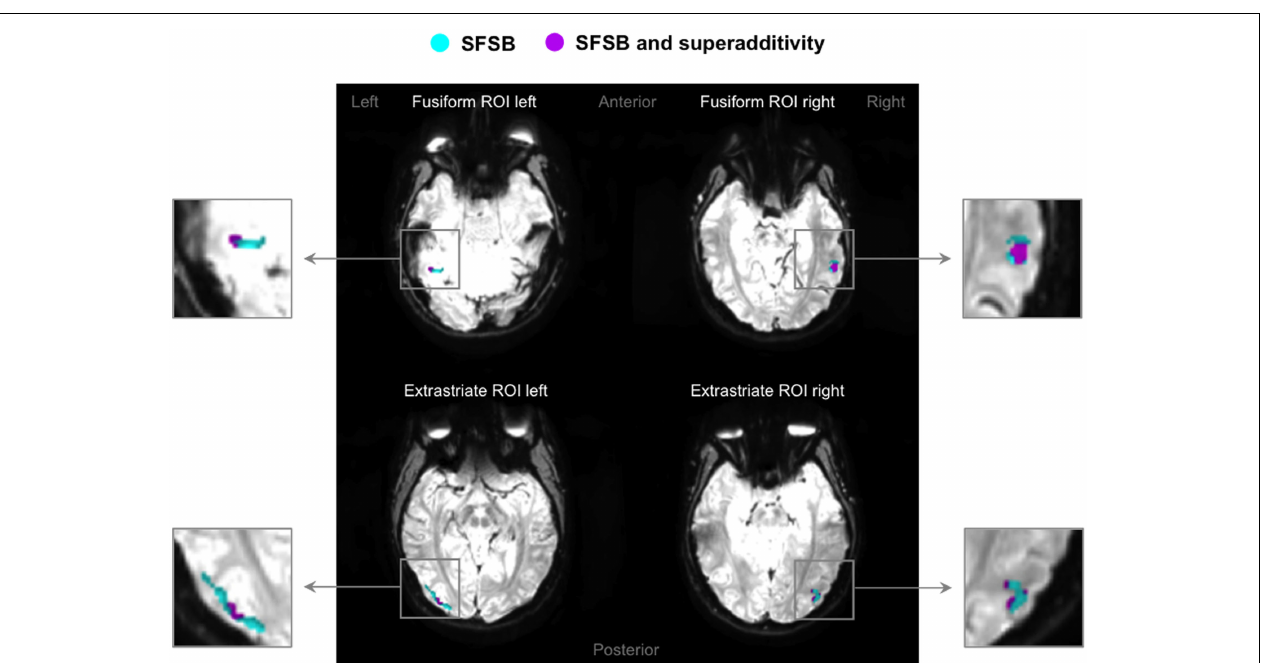
(cid:2) : SFSB voxels also showing superadditivity – (SFSB adaptation) > (SFDB adaptation + DFSB adaptation + DFDB adaptation). Contrasts were calculated using t -tests with family-wise error (FWE) corrections for multiple comparisons ( p <